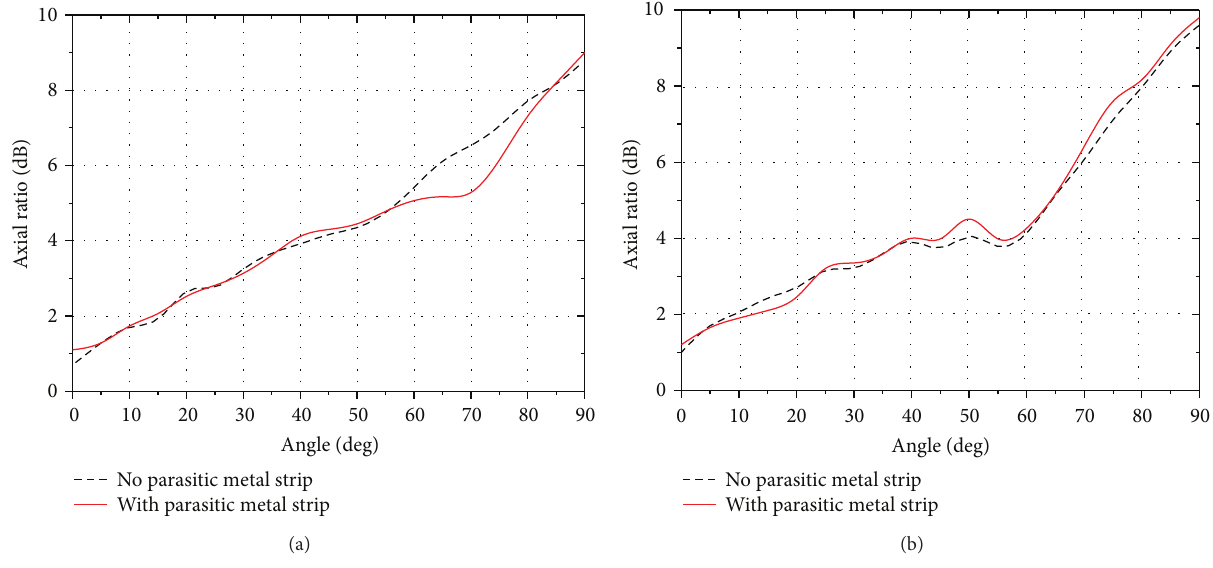
Figure 8: Axial ratio of the proposed dual-band CP antenna: (a) L1 band, (b) L2 band.